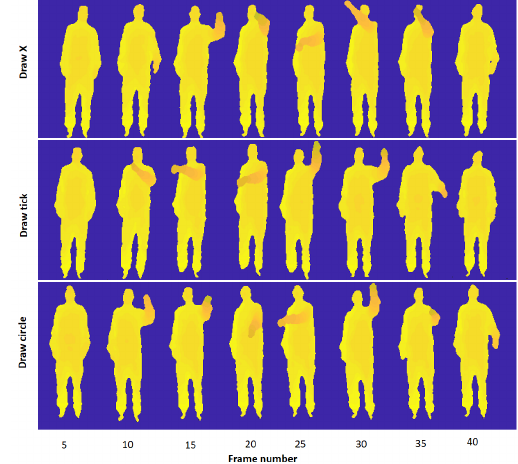
Figure 7. Interclass similarity across Draw x , Draw tick and Draw circle action sequences on MSR Action 3D